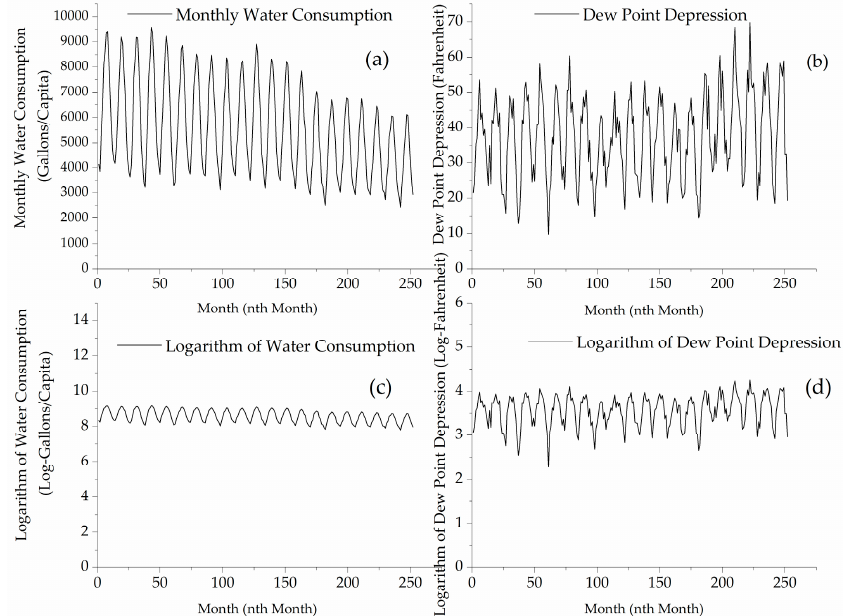
Figure 4. Plots of monthly time-series data and log-transformed time-series data for Las Vegas during 1990–2010: ( a ) monthly water consumption, ( b ) monthly average daily dew point depression, ( c ) natural log-transformed monthly water consumption, ( d ) natural log-transformed dew point depression.